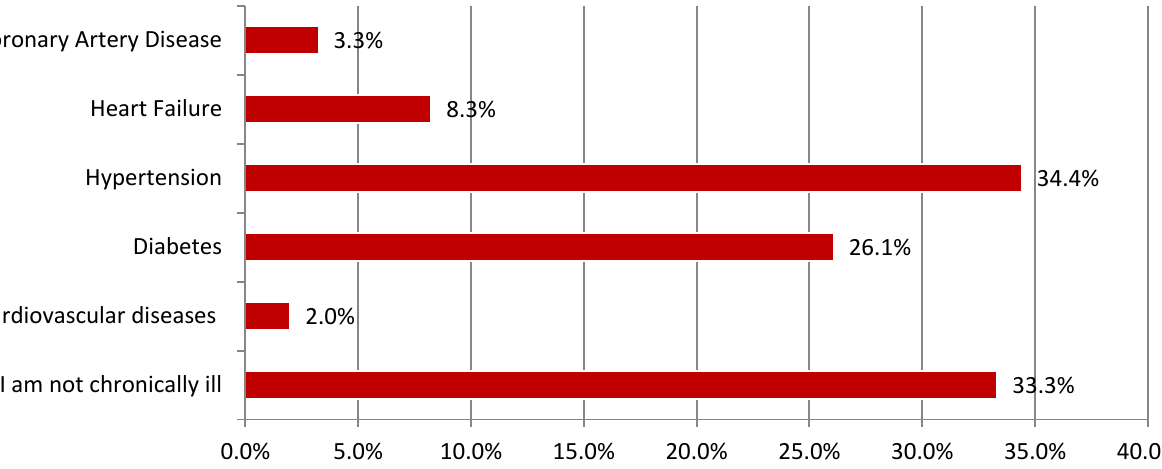
Figure 2. The chronic diseases among respondents ( “ I am not chronically ill ” control group). During a review of the patient’s health over the past 12 months, admission to a hospital due to the occurrence of chest pain or/and myocardial infarction was required only in